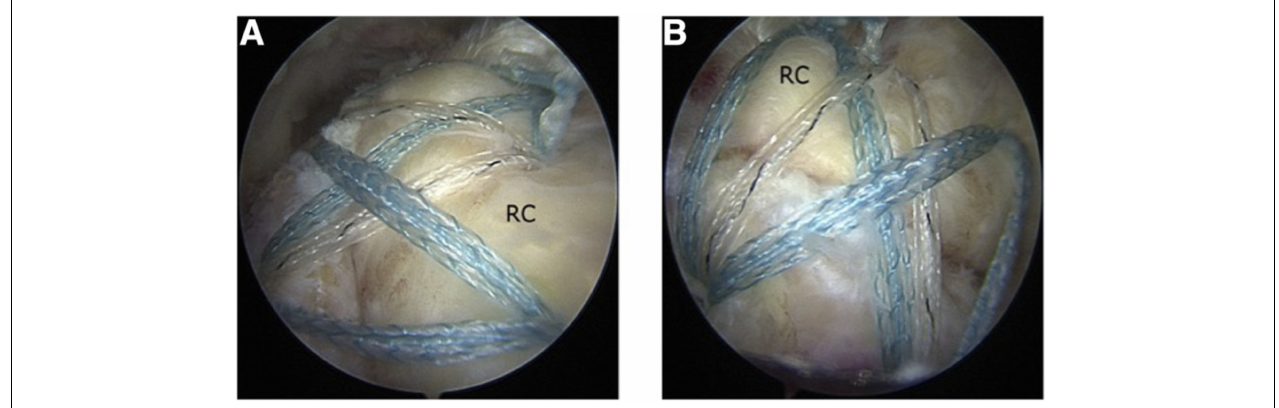
FIGURE 4 | Arthroscopic-assisted rotator cuff repair surgery (RC, rotator cuff) (Sheean et al., 2019). (A) Posterior subacromial viewing portal. (B) Lateral subacromial viewing